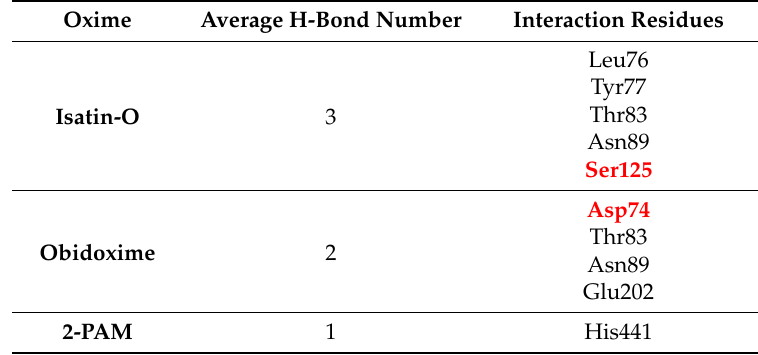
Table 4. Summary of MD results for all complexes Ee AChE/POX/ligands. The interacting residues observed also in docking studies are shown in